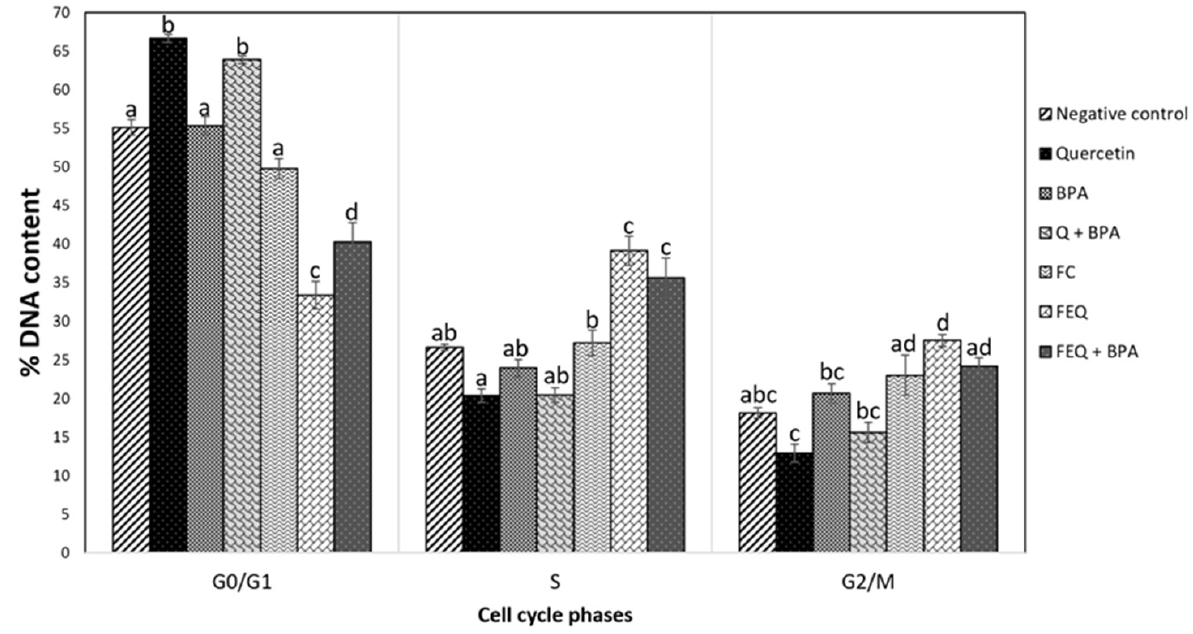
Figure 5. DNA content in the cycle phases of HT-29 cells treated with Q, FEQ and BPA. Concentra- tion of treatments: Q 160 μ M, BPA 4.4 μ M, FEQ 16%. FC: fermentation control. Each value represents two independent experiments in duplicate ± ES, expressed as percent DNA/500,000 cells. Different letters in a column indicate significant difference between each phase ( p < 0.05) by Tukey ’ s test. G 0 : resting phase, G 1 : 1st growth phase, S: DNA synthesis phase, G 2 : 2nd growth phase, M: mitosis phase.